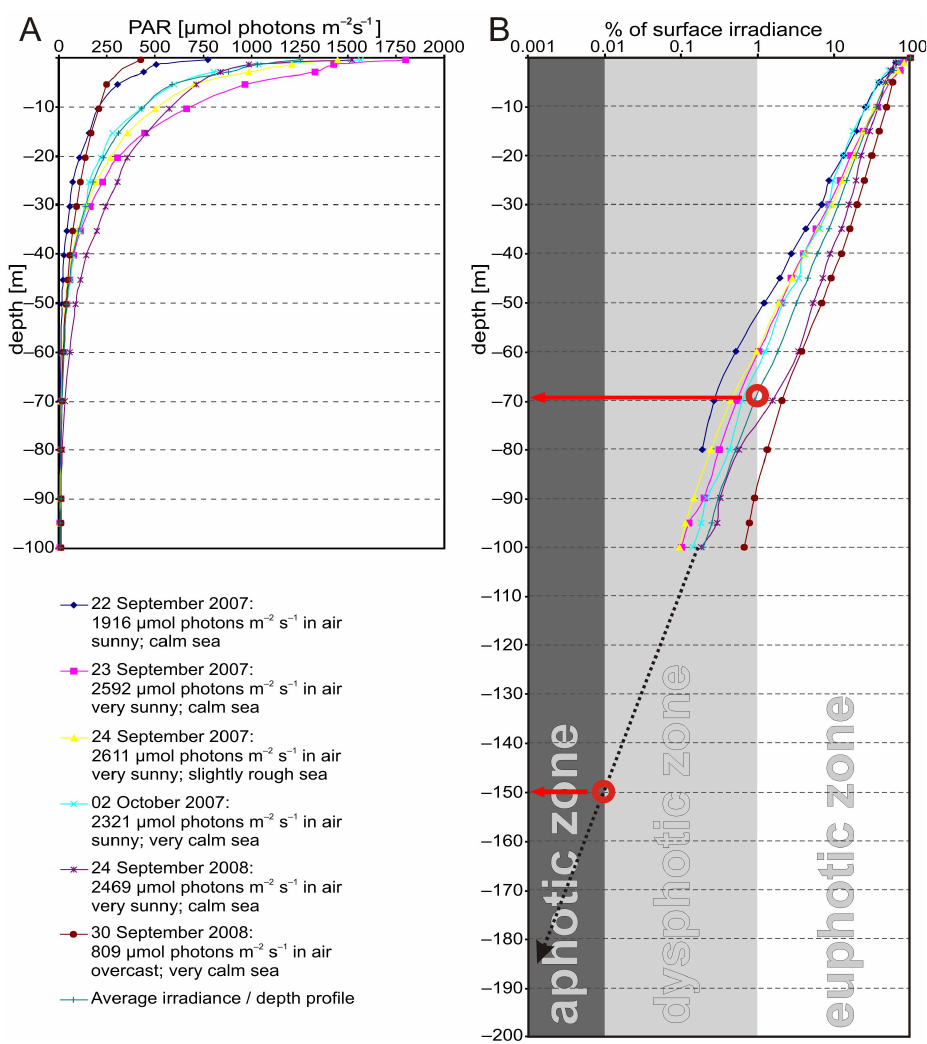
Fig. 4. Measurements of the photosynthetically active radiation (PAR; unit: µ mol photons m − 2 s − 1 ) with depth, carried out in the southern Faial Channel. (A) The irradiance exponentially decreases toward deeper waters. The surface irradiance in air, along with the weather conditions are given in the legend. (B) Semi-logarithmic plot of light intensities expressed as per cent of the surface irradiance measured just below the water surface, indicating a base of the euphotic zone (1% surface irradiance) in an average 70m of water depth and a base of the dysphotic zone ( ∼ 0.01% surface irradiance) in 150m,